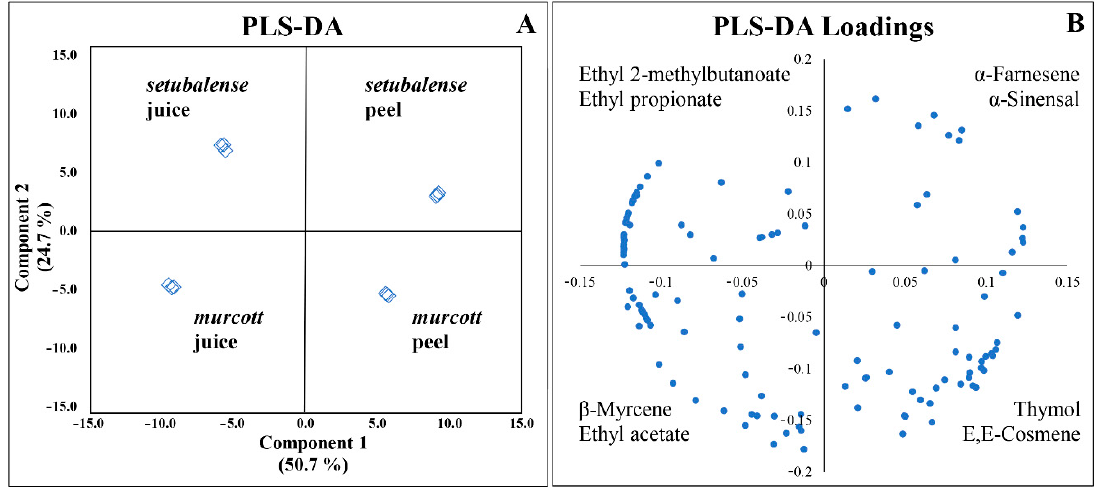
Figure 4. Multivariate statistical analysis (MVSA) using partial least square discriminant analysis (PLS-DA) of the volatomic data obtained ( A ) and identification of the variables (VOMs) responsible for the differentiation of the samples ( B ).